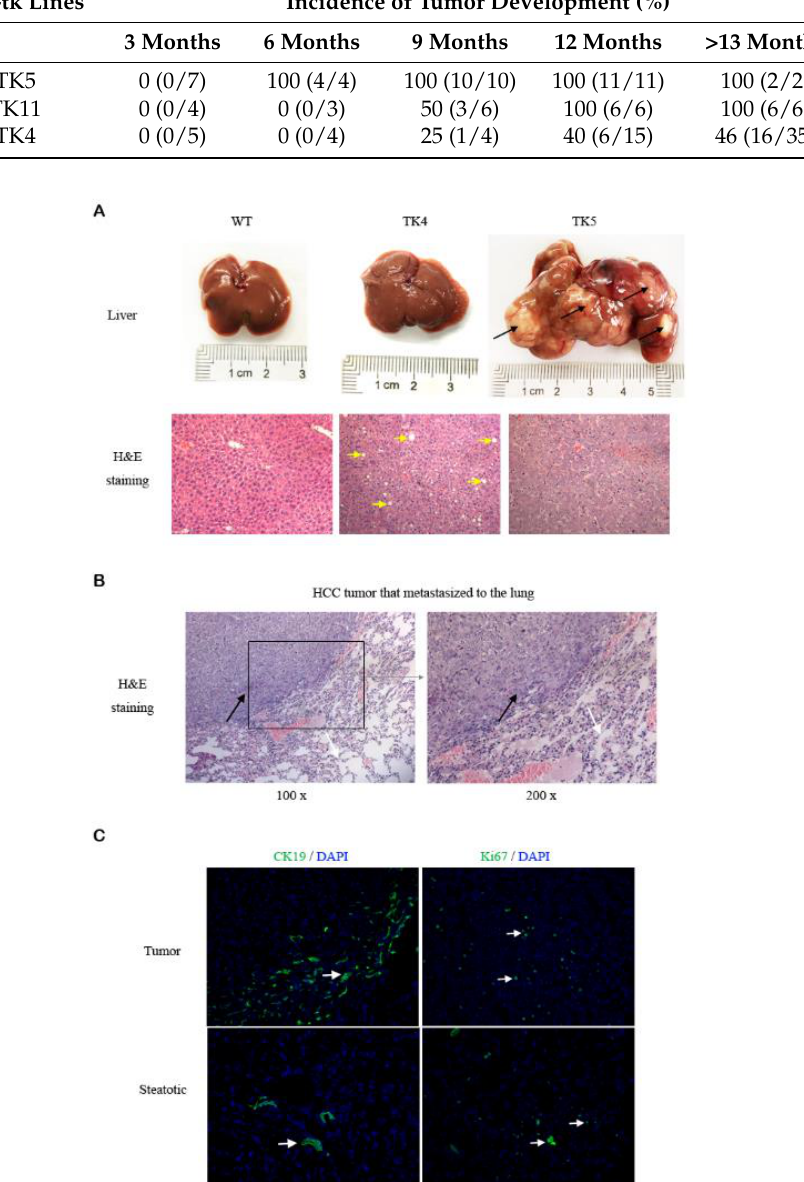
Figure 2. Histopathological analysis of hepatic steatosis and HCC in HSV-tk mice at 12 months of age. ( A ) Upper row images: gross tissue image of liver specimens from wild type (WT), TK4 and TK5 mice. No apparent change was observed in the liver of WT; steatosis was seen in the liver of line TK4 mouse and multiple tumors developed (black arrows) in the liver of TK5 mouse. Lower row images: histological analysis of the relevant WT, lines TK4 and TK5 mice liver. Note the marked steatotic changes in the TK4 liver (yellow arrows), and poorly differentiated tumor cells in the TK5 liver (H&E staining, Magnification, × 200); ( B ) HCC transferred to the lung in HSV-tk mice. Histological analysis of HCC transferred to the lung of a TK5 mouse at 13 months of age (HCC: black arrows, lung tissue: white arrows) (H&E staining); ( C ) Immunofluorescent observation for CK19 and Ki67 in HCC